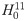
Distribution of average rise values (black line) for H011 (panel a), H114 (panel b) and H216 (panel c). Average rise values for present sequences (green plot) are also reported in the three panels.